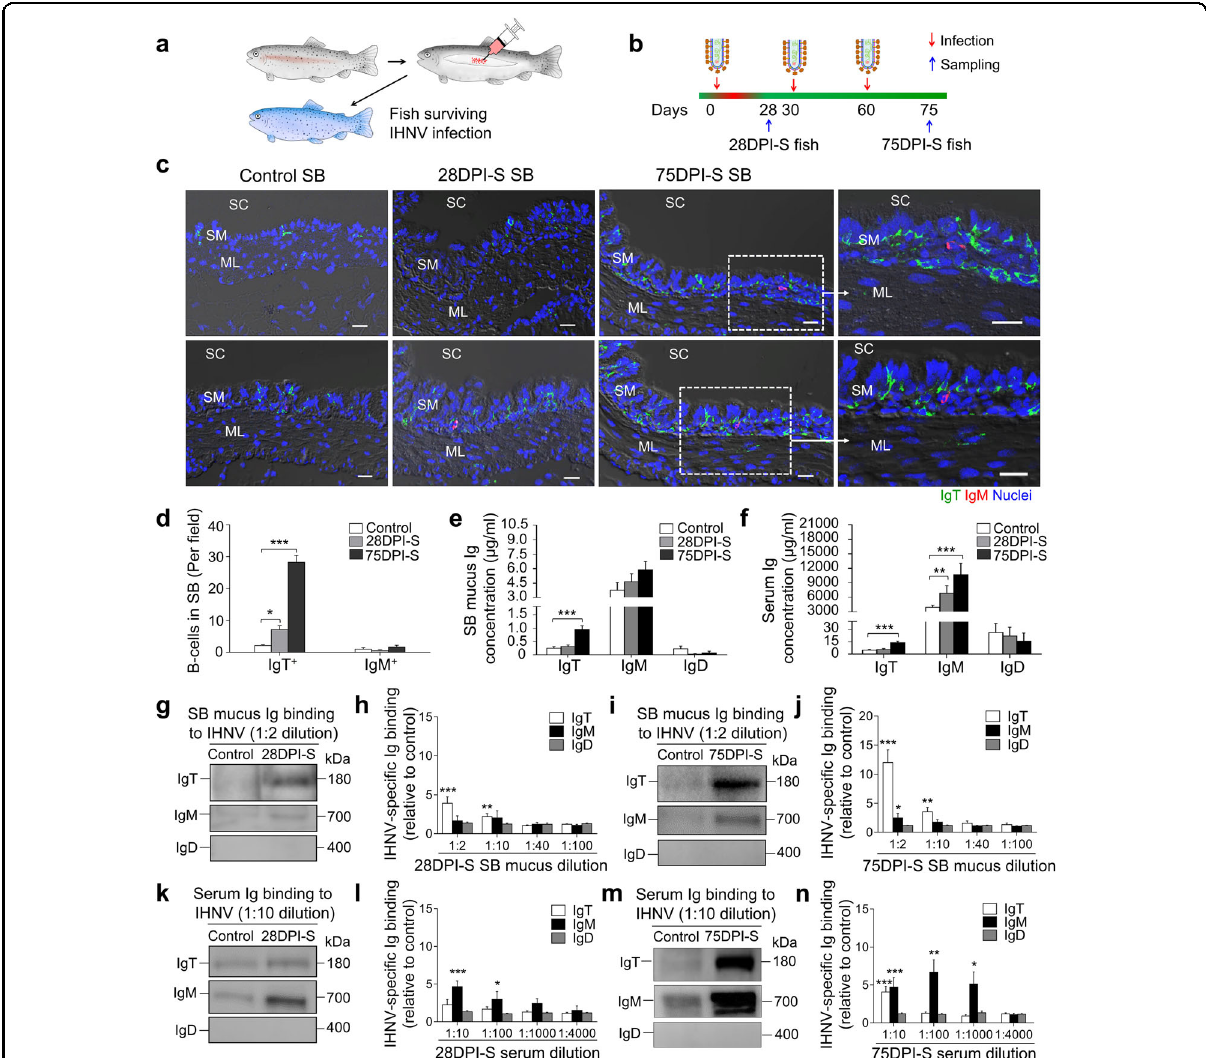
Fig. 4 Increases in IgT + B-cells and IHNV-speci fi c sIgT responses in the SB mucosa of trout infected with IHNV. a , b Scheme of the infection strategy with IHNV via SB injection. Fish were injected with 25 μ L of virus (1 × 10 5 TCID 50 ) and one group of surviving fi sh was sacri fi ced at 28 DPI (28DPI-S group) while another group was reinfected twice at 30 and 60 DPI with the same viral dose, and the resulting surviving fi sh were sacri fi ced at 75 days after the fi rst infection (75DPI-S group). c Differential interference contrast (DIC) images of immuno fl uorescence staining on trout SB paraf fi n-sections from uninfected (control) fi sh, 28DPI-S and 75DPI-S fi sh, stained for IgT (green) and IgM (red) (Isotype-matched control antibody staining is shown in Supplementary Fig. S2c); nuclei (blue) were stained with DAPI (blue). SC SB cavity, SM SB mucosa, ML muscle layer. Scale bars, 20 μ m. d The number of IgT + and IgM + B-cells in SB paraf fi n-sections of control, 28DPI-S and 75DPI-S fi sh counted from c ( n = 9). e , f Concentration of IgT, IgM, and IgD protein in SB mucus ( e ) and serum ( f ) of control, 28DP-S, and 75DPI-S fi sh ( n = 9 – 16). g , i Western blot analysis of IgT-, IgM-, and IgD-speci fi c binding to IHNV in SB mucus (dilution 1/2) from 28DPI-S ( g ) and 75DPI-S fi sh ( i ). h , j IgT-, IgM- and IgD-speci fi c binding to IHNV in dilutions of SB mucus from 28DPI-S ( h ) and 75DPI-S ( j ) fi sh evaluated by densitometric analysis of immunoblots and presented as relative values to those of control fi sh ( n = 8 – 12). k , m Western blot analysis of IgT-, IgM-, and IgD-speci fi c binding to IHNV in serum (dilution 1/10) from 28DPI-S ( k ) and 75DPI-S fi sh ( m ). l , n IgT-, IgM-, and IgD-speci fi c binding to IHNV in dilutions of serum from 28DPI-S ( l ) and 75DPI-S ( n ) fi sh evaluated by densitometric analysis of immunoblots and presented as relative values to those of control fi sh ( n = 8 – 12). Statistical differences were evaluated by one-way ANOVA with Bonferroni correction ( d – f ) and were performed by unpaired Student ’ s t -test ( h , j , l , n ). Data are representative of at least three independent experiments (mean± SEM). * P < 0.05, ** P < 0.01, and *** P <